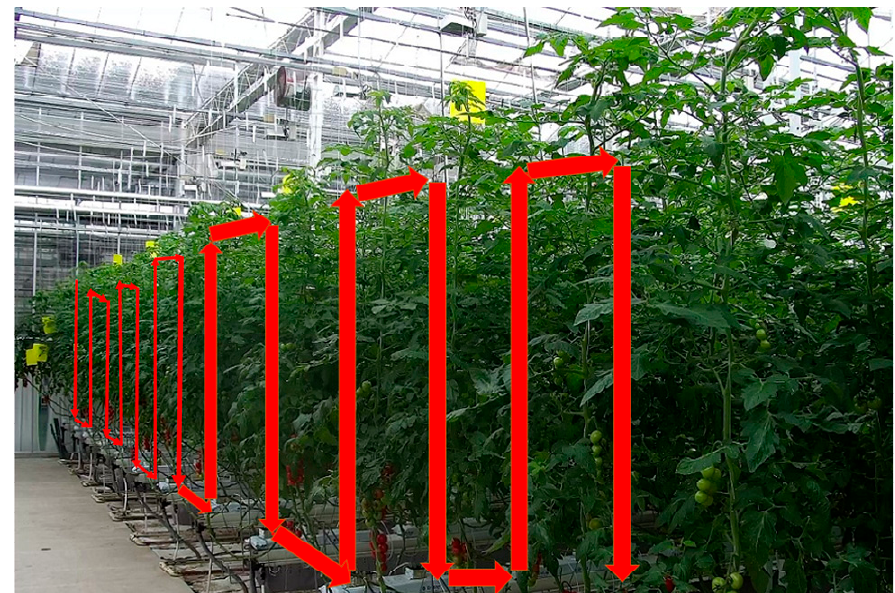
Figure 16. The cruise trajectory (red line with arrows) of our shooting strategy: moving up and down with varied focal length from the first row to the last.